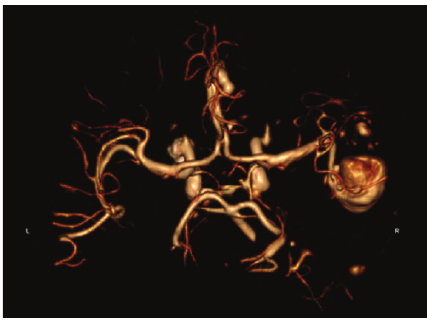
Figure 1: CT angio of the head showing two myxomatous fusiform aneurysms in the right middle (2.9cm × 1.8cm) and anterior cerebral arteries (10mm × 5mm).